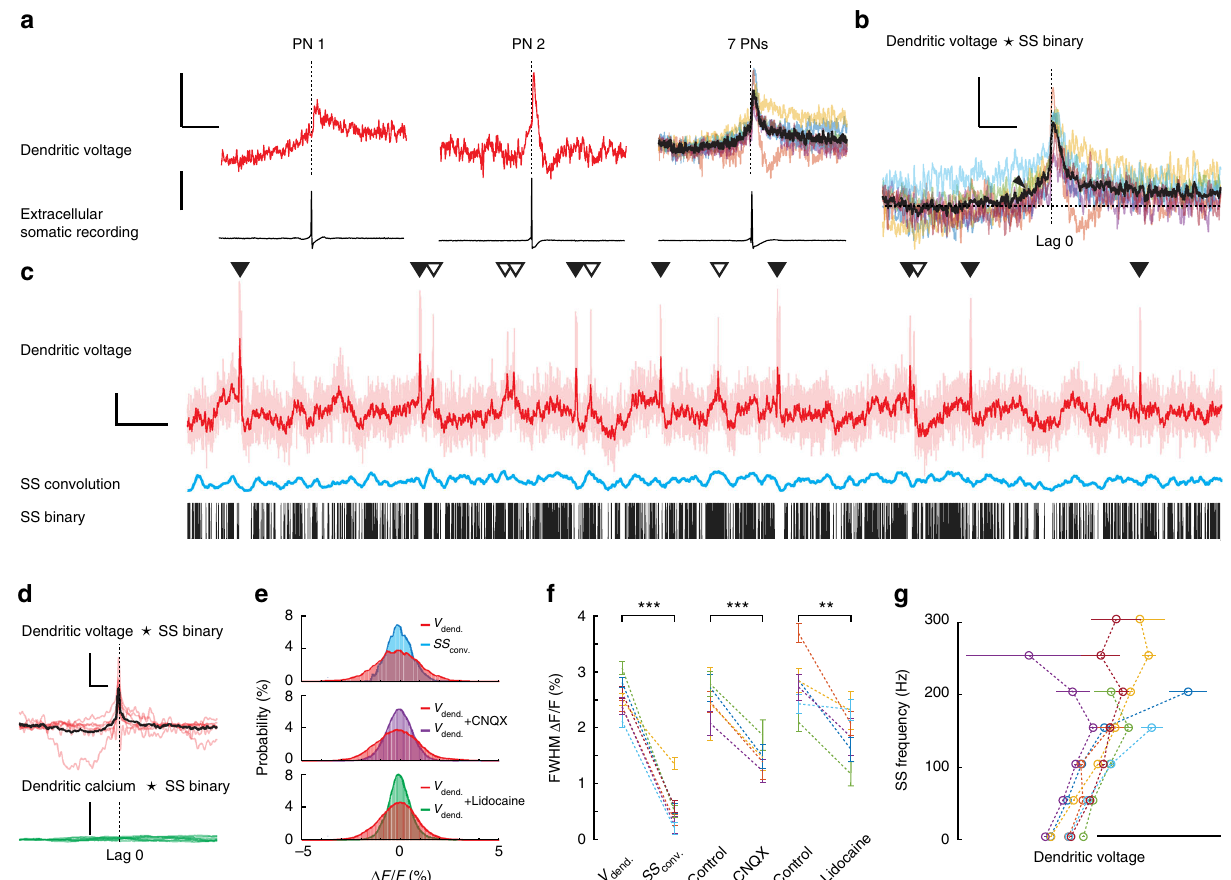
Fig. 4 Subthreshold dendritic voltage reveals back-propagating action potentials and regimes of linear and nonlinear relationship with somatic activity. a Back-propagating action potentials (SS) recorded from PN spiny dendrites in awake mice, showing the most (left: 3614 averages) and least (middle: 1799 averages) attenuated signals recorded from different PNs, and signals from all seven PNs (right: black trace is group average). Voltage vertical scale bar 0.5% Δ F / F , corresponding to about 1 mV; extracellular somatic recording vertical scale bar 50 pA; horizontal scale bar 20 ms. b Cross-correlation (CC) between SS binary signal (recorded at the soma) vs. spiny dendrite membrane potential. Black arrow indicates dendritic depolarization preceding SS initiation. Vertical scale bar 0.5% Δ CC/CC; horizontal scale bar 10 ms. c 10 s of dendritic voltage recording, spatially averaged (light red trace). Dark red trace is dendritic voltage with 10 ms temporal fi ltering. Simultaneously recorded SSs are shown with binary (black bars), and corresponding convolution of back-propagating SS signal and SS binary (blue trace). Vertical scale bar 5% Δ F / F ; horizontal scale bar 500 ms. d Normalized cross-correlations between fi ltered dendritic voltage and SS binary traces (red traces, black trace is group average; vertical scale bar 3% Δ CC/CC; horizontal scale bar 100 ms) and between corresponding dendritic calcium and SS binary traces (green traces; vertical scale bar 0.3% Δ CC/CC). e Normalized probability distributions of dendritic voltage (red) and SS convolution voltage (blue) calculated using all recordings from PN shown in c , (top); of dendritic voltage (red) and dendritic voltage during CNQX application (purple) calculated from a single PN (middle); and of dendritic voltage (red) and dendritic voltage during lidocaine application (green) calculated from a single PN (bottom); DCS and DS events were excluded. f Full width at half maximum (FWHM) of the corresponding dendritic voltage probability distributions measured from individual PNs (5 − 7 PNs per group), bars show mean ± s.d. of shot noise, paired two-tailed t test, *** p < 0.001, ** p < 0.01. g Relationships between average dendritic voltage and somatic SS frequency recorded from seven PNs, calculated using a 20 ms kernel with 1 ms increments. Scale bar 5 mV. Bars show mean ±